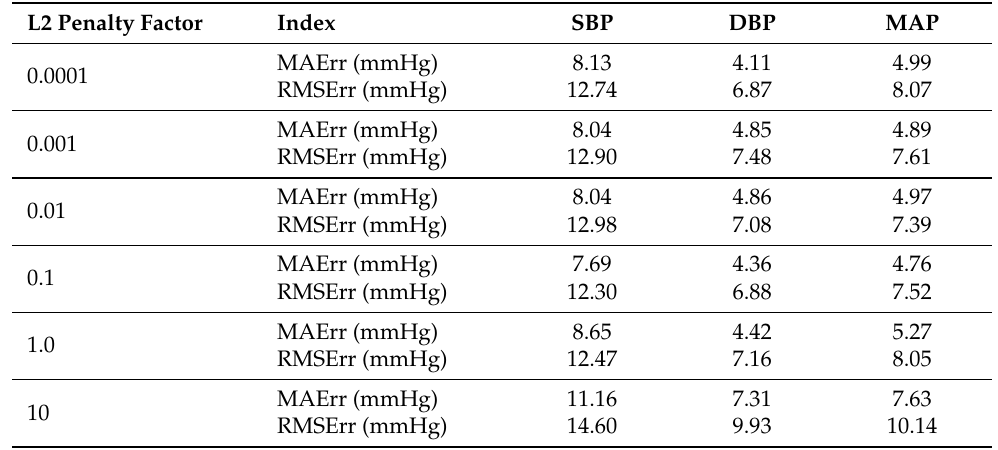
Table 7. BP Measurement Performance of the Proposed Method with Different L 2 penalty